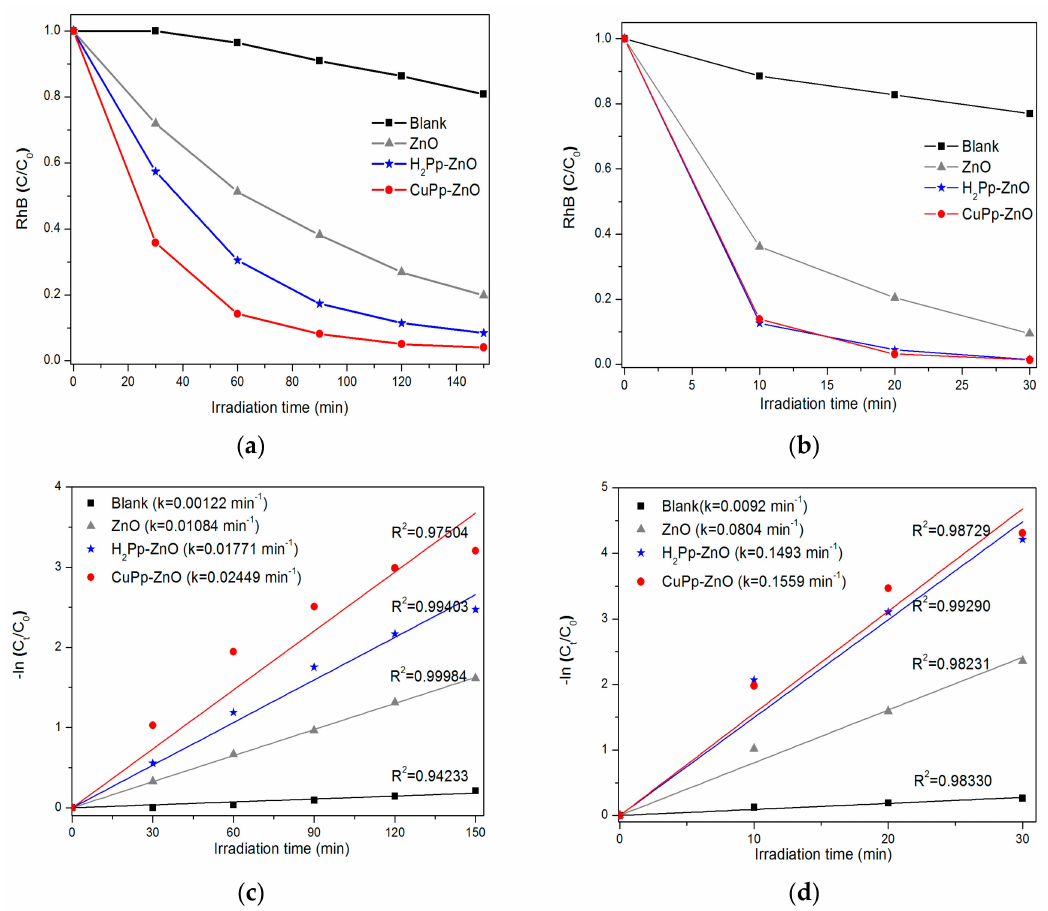
Figure 6. Photodegradation of RhB vs. irradiation time by bare ZnO, H 2 Pp–ZnO, and CuPp–ZnO photocatalysts ( a ) under visible light irradiation; and ( b ) under natural sunlight irradiation. Kinetic model of pseudo-first order for RhB photodegradation under irradiation of visible light ( c ); and natural sunlight ( d